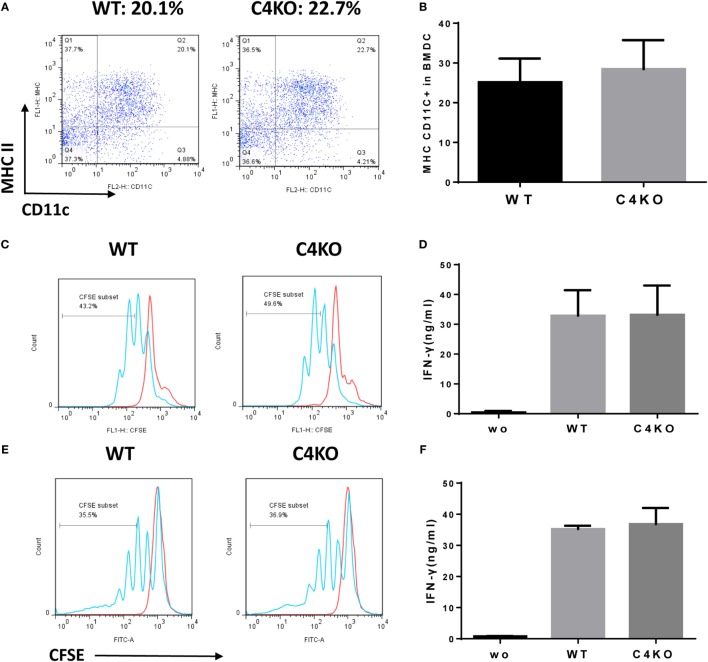
Effects of C4 deficiency on DC differentiation and function. BM cells from naïve wild-type (WT) and C4 KO mice were cultured under DC differentiation conditions and differentiated double-positive cells (DCs) (MHCII+ CD11C+) analyzed by flow cytometry. (A,B) Representative flow cytometric analysis results for WT and C4 KO DC differentiation (A) and the summarized results (B) [n = 5 in each group, mean ± SEM]. (C,D) The same numbers of BM-derived WT or C4 KO DCs was then cultured with carboxyfluorescein succinimidyl ester (CFSE)-labeled T cells from OTII mice in the presence or absence (wo) of peptide OVA323–339 for 72 h, then the proliferation of the activated T cells was assessed by flow cytometry (C) and levels of interferon (IFN)γ produced by the activated T cells measured by ELISA (D) (n = 5 in each group). The same T cell proliferation (E) and IFNγ (F) assays were done using splenic DCs isolated from WT and C4 KO mice (n = 3 in each group), no statistically significant difference was observed either (mean ± SEM).